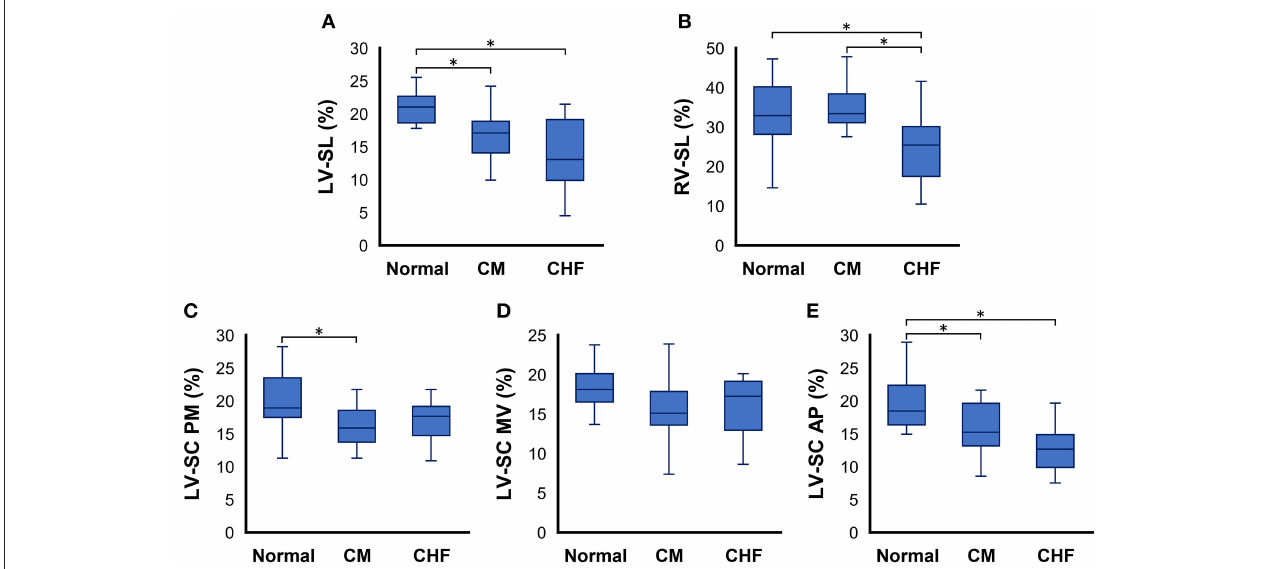
FIGURE 1 | Box and whisker plots of two-dimensional speckle tracking echocardiography indices in cats with cardiomyopathy. (A) left ventricular longitudinal strain (LV-SL), (B) right ventricular longitudinal strain (RV-SL), (C) left ventricular circumferential strain (LV-SC) at the papillary muscles level of the left ventricle (PM), (D) LV-SC at the mitral valve level of the left ventricle (MV), and (E) LV-SC at the apical level of the left ventricle AP, respectively. * The value is significantly different between groups ( P < 0.05).